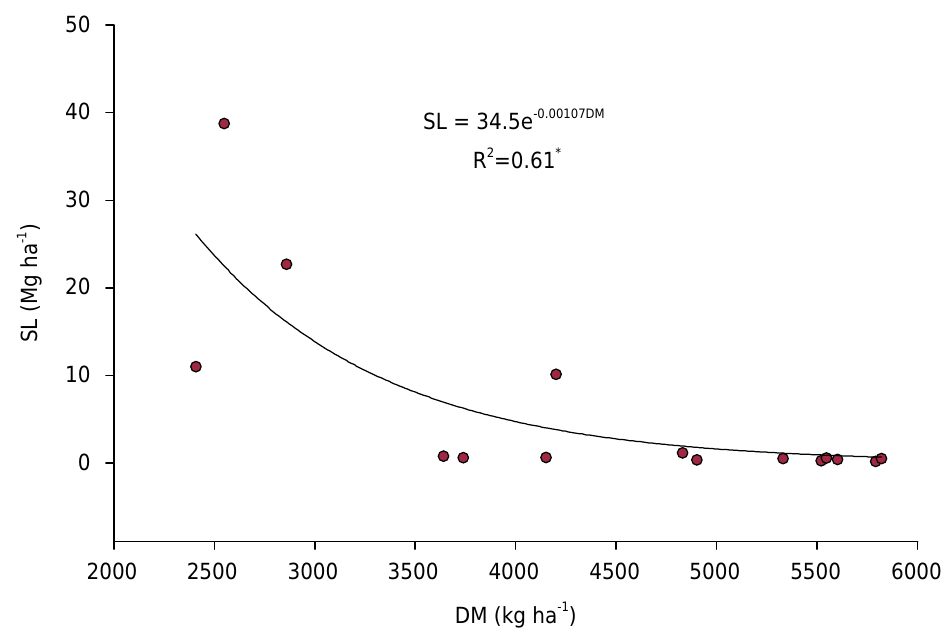
Figure 3. Relationship between soil losses (SL) and dry massof aerial part of the crops (DM) in treatments with forage turnip, black bean, and common vetch, in experiment I. *: